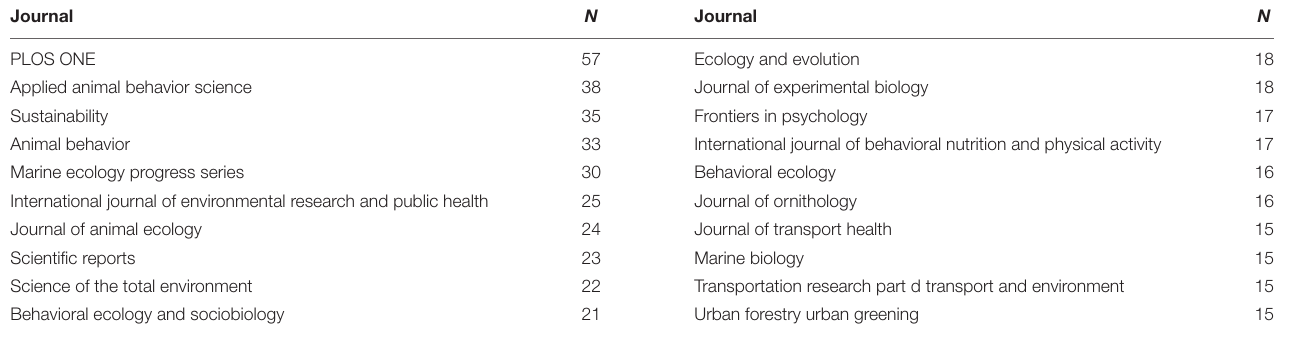
TABLE 2 | Journal distribution of literature on citizen environmental behavior (top